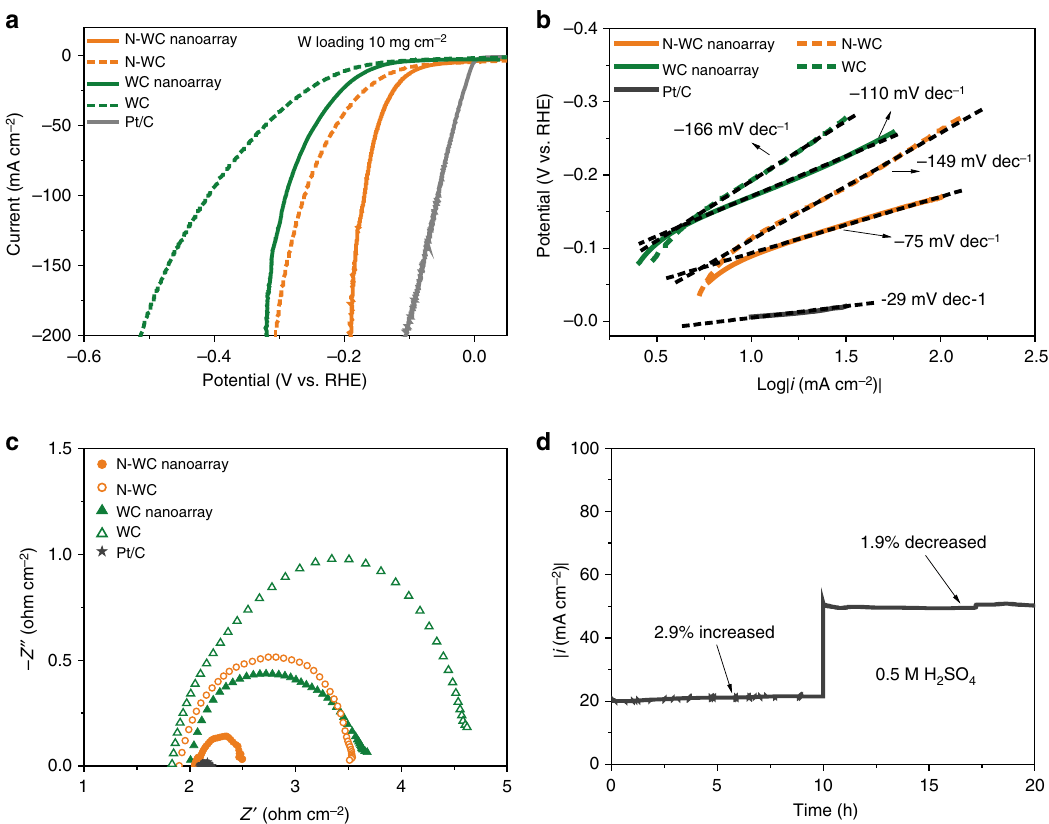
Fig. 4 HER performance and comparison. a LSV of commercial Pt/C, WC, WC nanoarray, N-WC, and N-WC nanoarray in 0.5 M H 2 SO 4 with iR correction at a scan rate of 1 mV/s. b Tafel plots calculated from a . c AC impedance of WC, WC nanoarray, N-WC, N-WC nanoarray, and commercial Pt/C catalysts. d Stability test of N-WC nanoarray at the overpotential of − 0.144 V for 10 h, and then − 0.156 V for another 10 h with iR